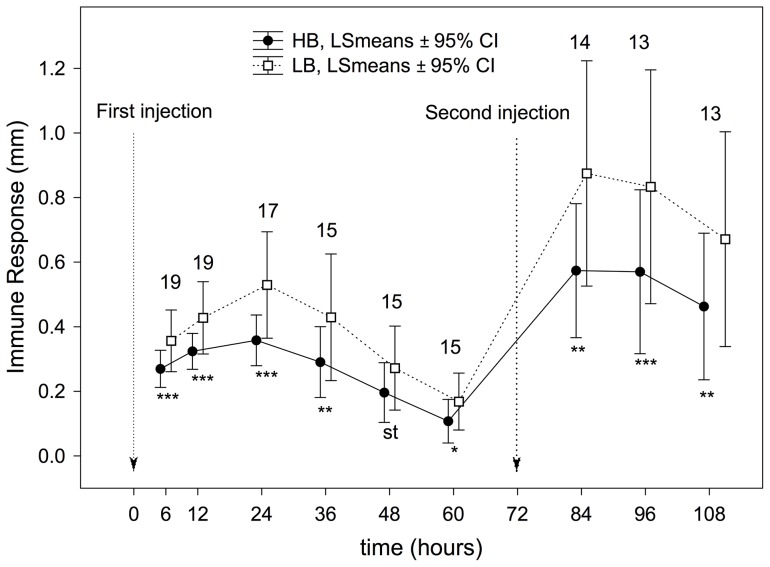
Effect of the experimental treatment on immune response calculated from RM-ANOVAs performed for each experimental session.P-values associated with differences in each experimental session are indicated as ns: P>0.05; st: 0.1≤P≥0.05; *: P<0.05; **: P<0.001 and ***: P<0.0001. Numbers of nests (i.e. those with measurements from the four nestlings) used in each of the comparisons are also shown.